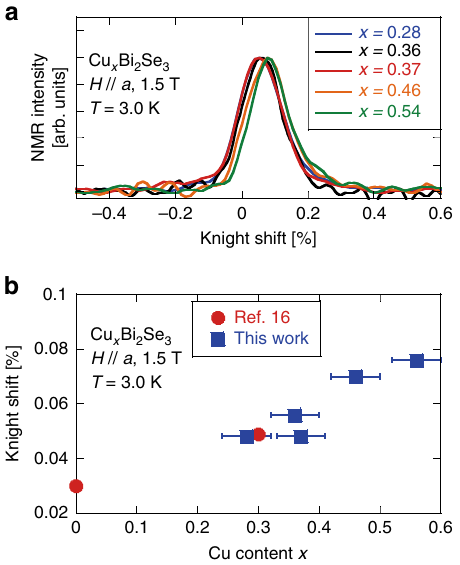
Fig. 3 NMR Spectra and Knight shift. a The 77 Se-NMR spectra measured in a magnetic fi eld of H 0 = 1.5 T. b Cu content x dependence of the Knight shift. Data for x = 0 and 0.3 are from ref. 16 . The error for Cu-content x was determined by the resolution of the electronic balance used for measuring the weight of samples.